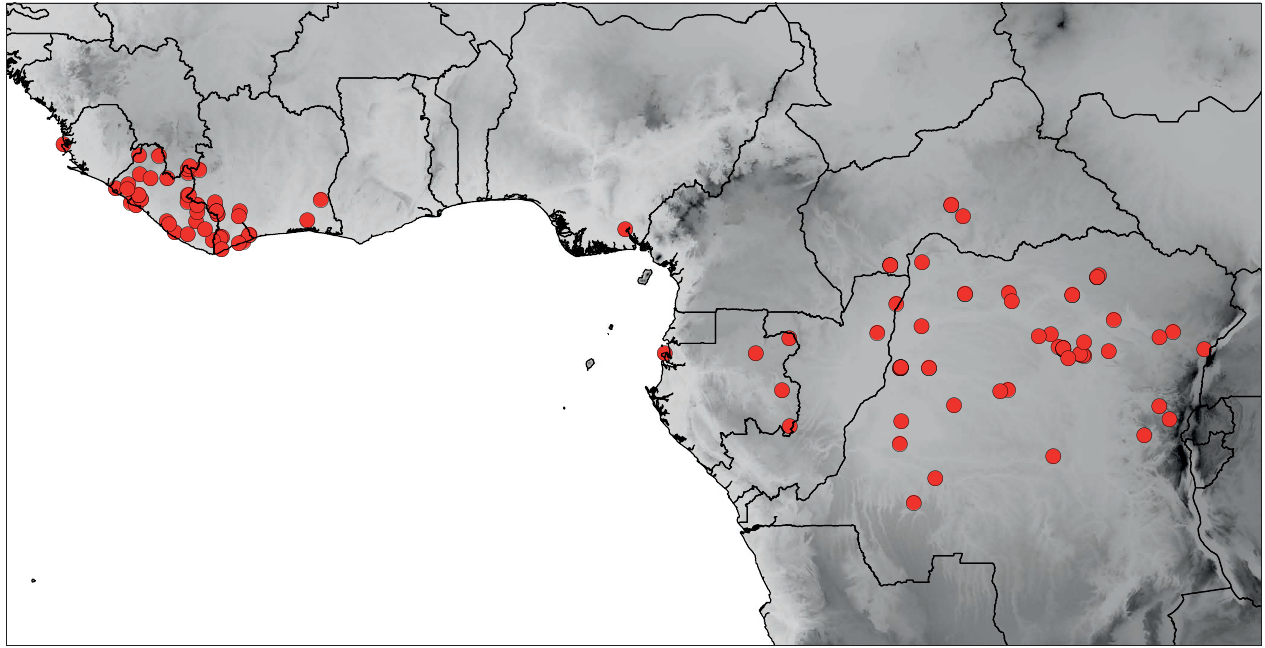
Figure 6 – Distribution of Kolobopetalum ovatum . Map created with ArcMap 10.7.1 (ArcGIS Desktop v.10.7.1; Esri 2019). © Esri and its licensors, all rights